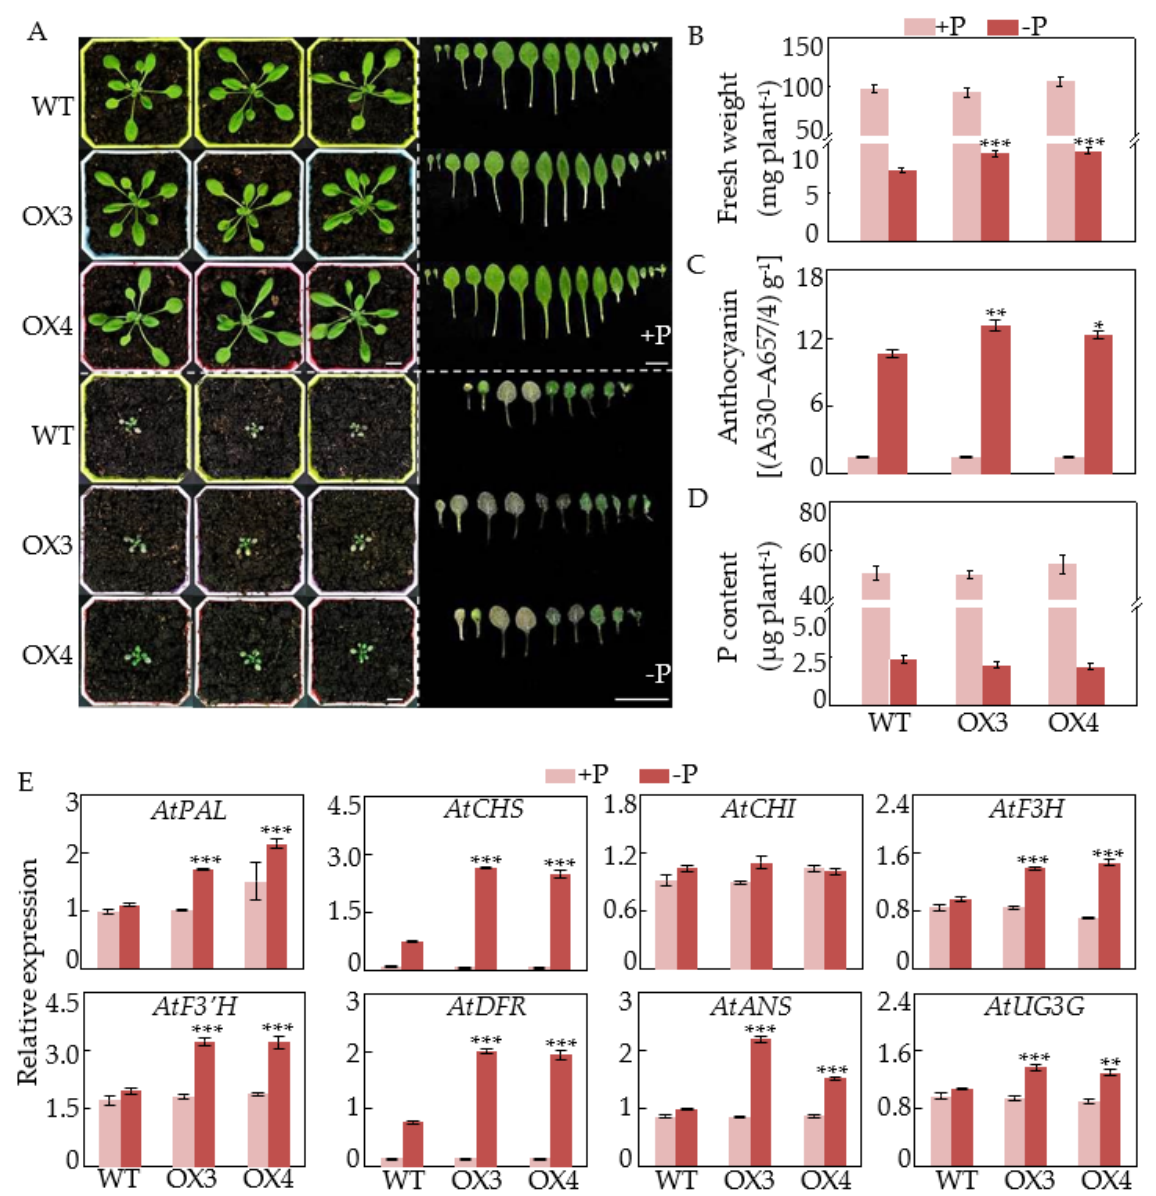
Figure 6. Effects of GmCSN5B overexpression on anthocyanin accumulation in Arabidopsis. ( A ) The phenotypes. Bars = 1 cm. ( B ) Fresh weight. ( C ) Anthocyanin content. ( D ) P content. ( E ) Relative expression of eight genes in anthocyanin biosynthetic pathway. Seedlings were grown in peat soils for 13 d. Data are means of four independent replicates ± SE. Asterisks indicate significant difference between GmCSN5B overexpressing Arabidopsis and WT in the Student’s t -test (* p < 0.05; ** p < 0.01; *** p < 0.001).